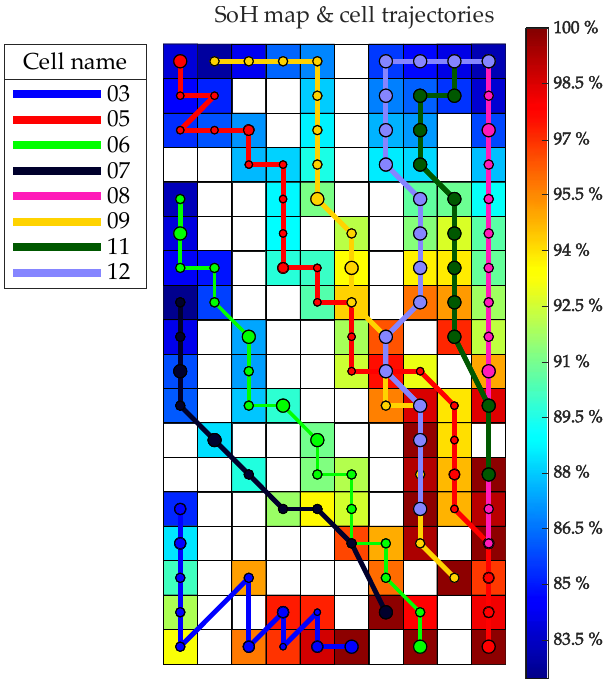
Figure 12. Eight cell trajectories on the SoH map (trained by using 5th order polynomial feature extraction).